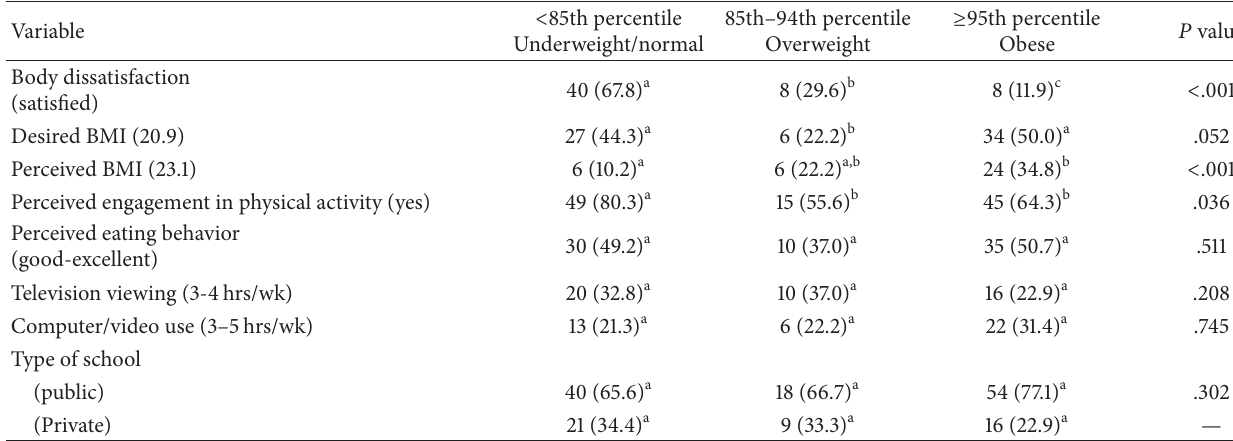
Table 1: General characteristics by BMI category.